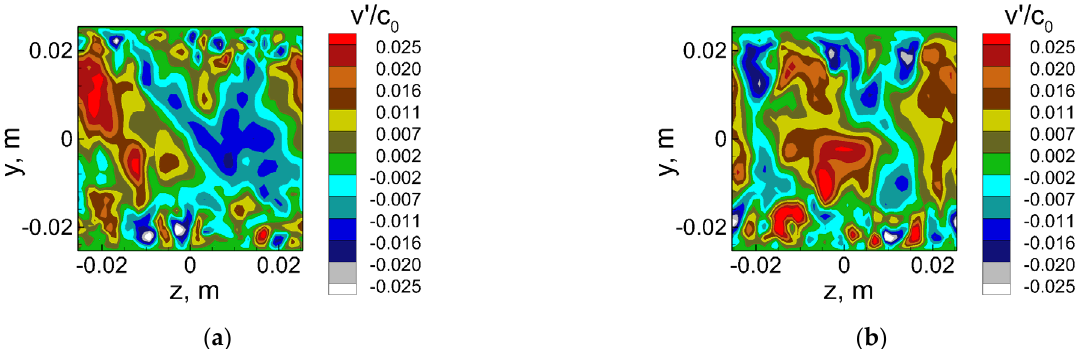
Figure 9. Instantaneous fields of fluctuations of vertical (normal to the lined wall) velocity at x = 0.6 m from WMLES of flows in the duct with solid walls using original governing equations ( a ) and in the duct with liner using equations with added stabilization body force SRC1 (7) at B D = 0.4 ( b ).